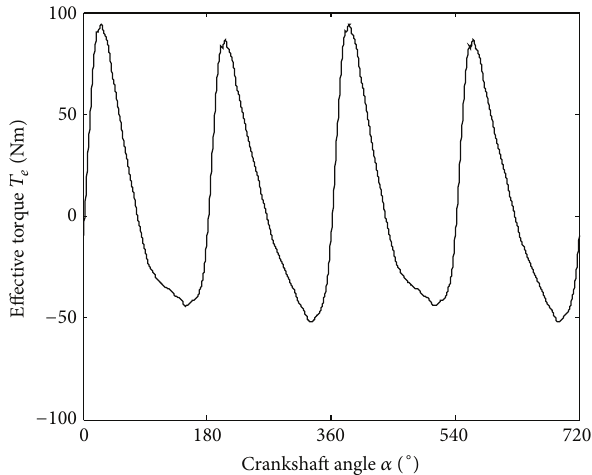
Figure 6: Effective output torque of the